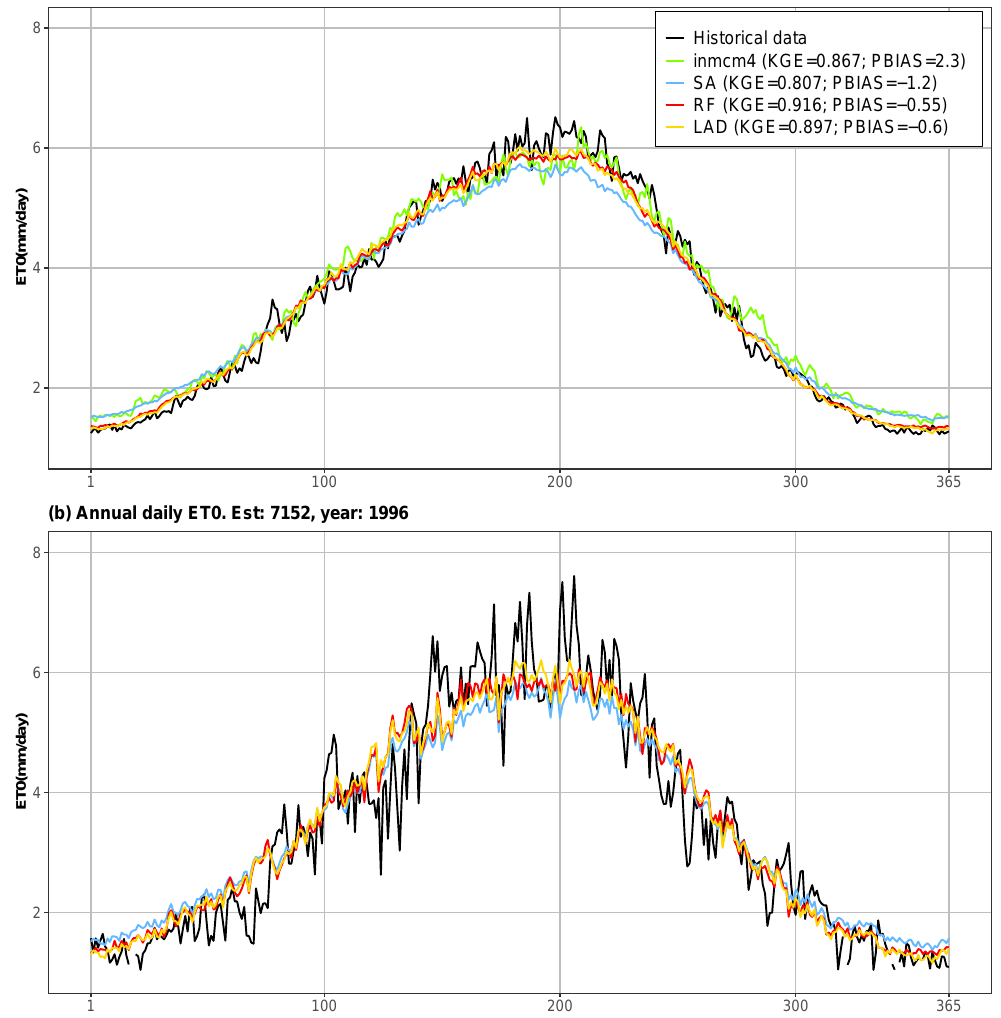
Figure 4. Daily ET 0 (mm day − 1 ) of a hypothetical year ( a ) and 1996 ( b ). Series in subfigure ( a ) represent mean values of historical data and the best of the individual regionalized models, and the predictions of the two best MMEs and SA, obtained using as input proxies the daily mean values of the individual regionalized models. In subfigure ( b ), no individual regionalized model is included for better visualization. Goodness of fit statistics for the entire validation series are included in the